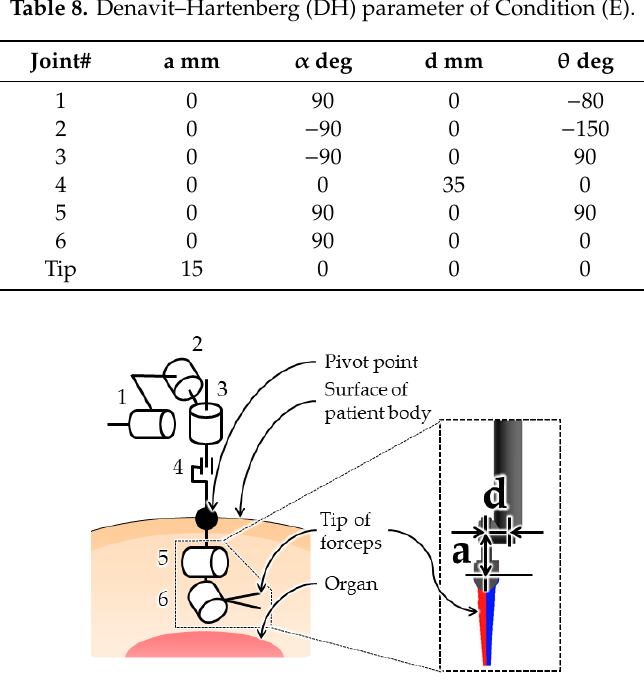
Figure 4. Mechanical configuration.